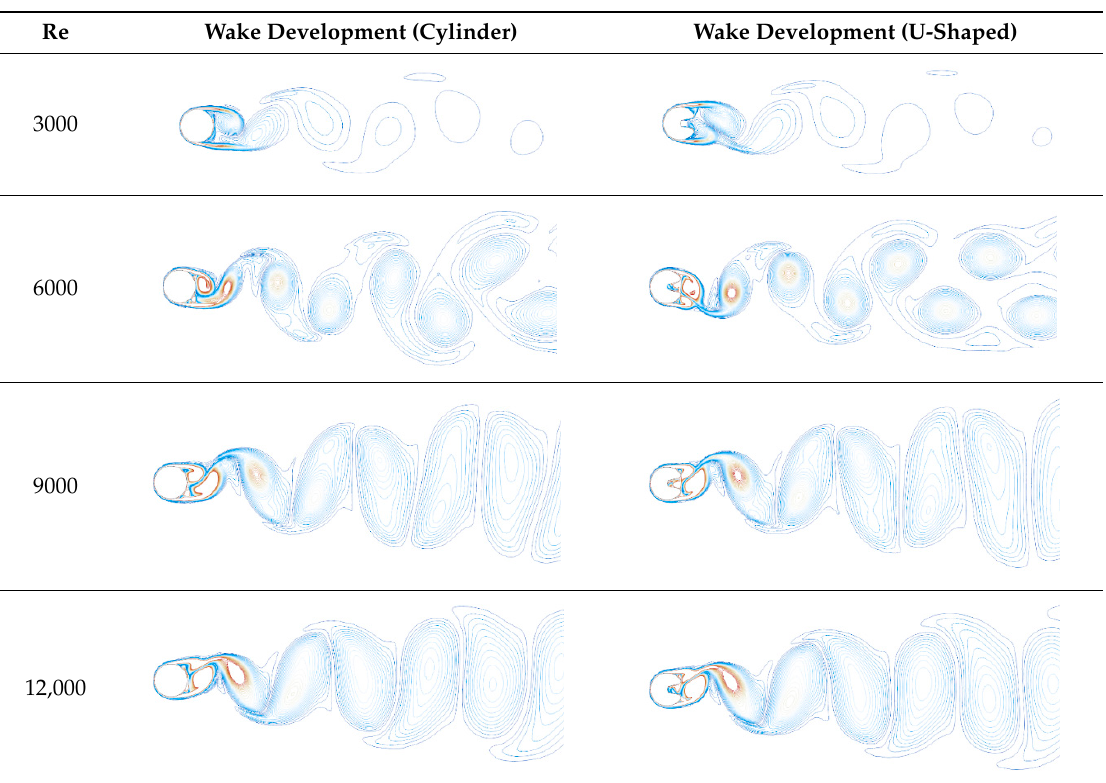
Table A1. Vortex shedding comparison behind the circular cylinder and the U-shaped geometry at different Reynolds numbers where D = 10 mm.